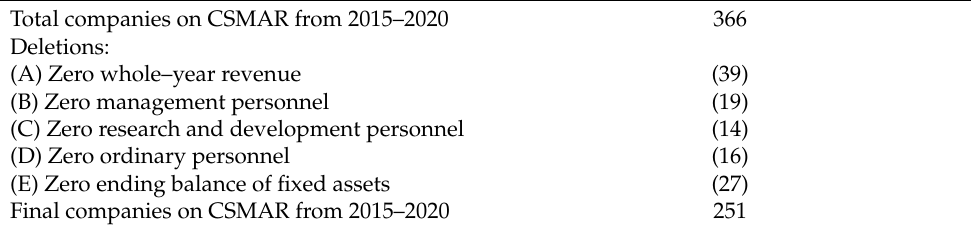
Table 1. Sample selection for this